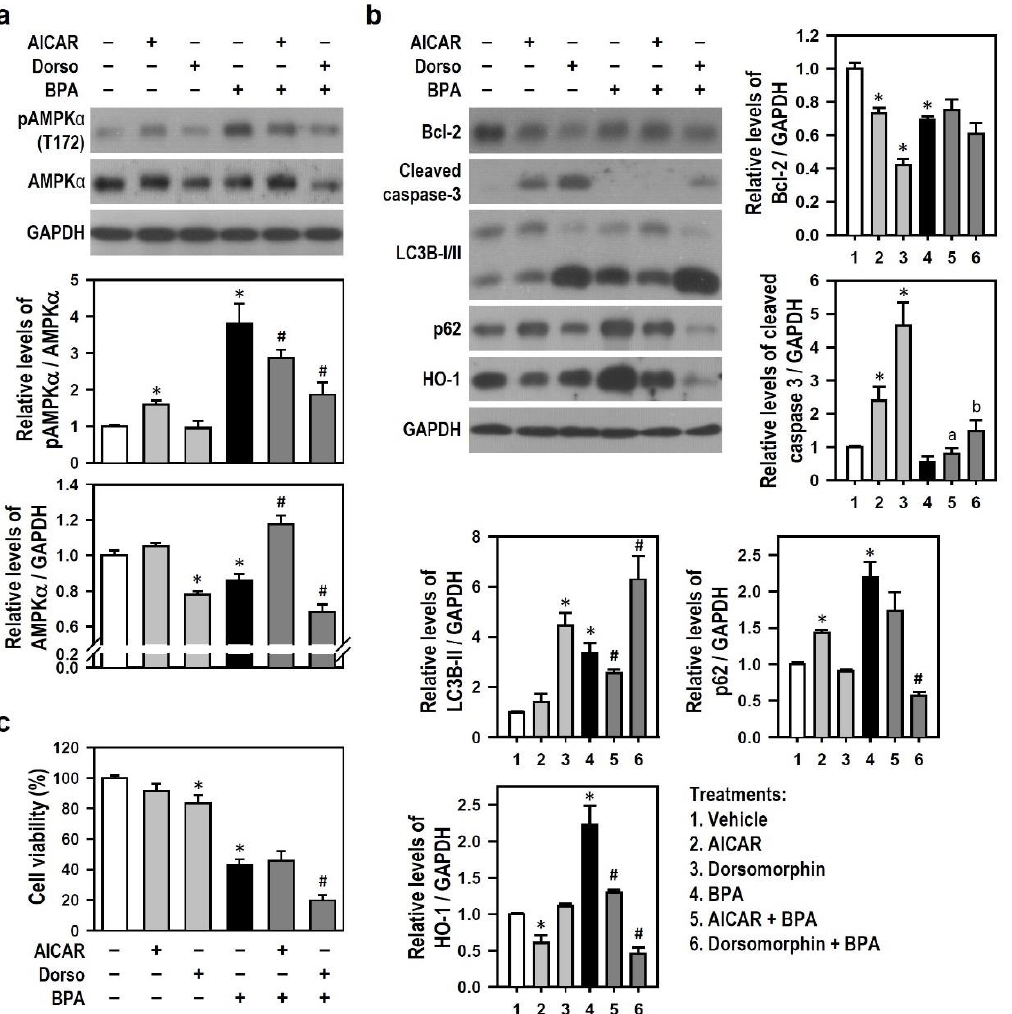
Figure 8. AMPK activated by BPA is related to the levels of p62 and LC3B; AICAR lessens BPA-induced formation of LC3B and HO-1, while dorsomorphin reduces BPA-induced p62 accumulation and aggravates N2a cell death caused by BPA. ( a ) Cultures were exposed to AMPK-related pharmacological agents, i.e., 2 mM 5-aminoimidazole-4-carboxamide riboside (AICAR) or 10 μM dorsomorphin (Dorso), for 30 min before being treated with or without 100 μM BPA for 24 h. The levels of pAMPKα and AMPKα were detected by Western blots. The bar plots show the quantitative data of